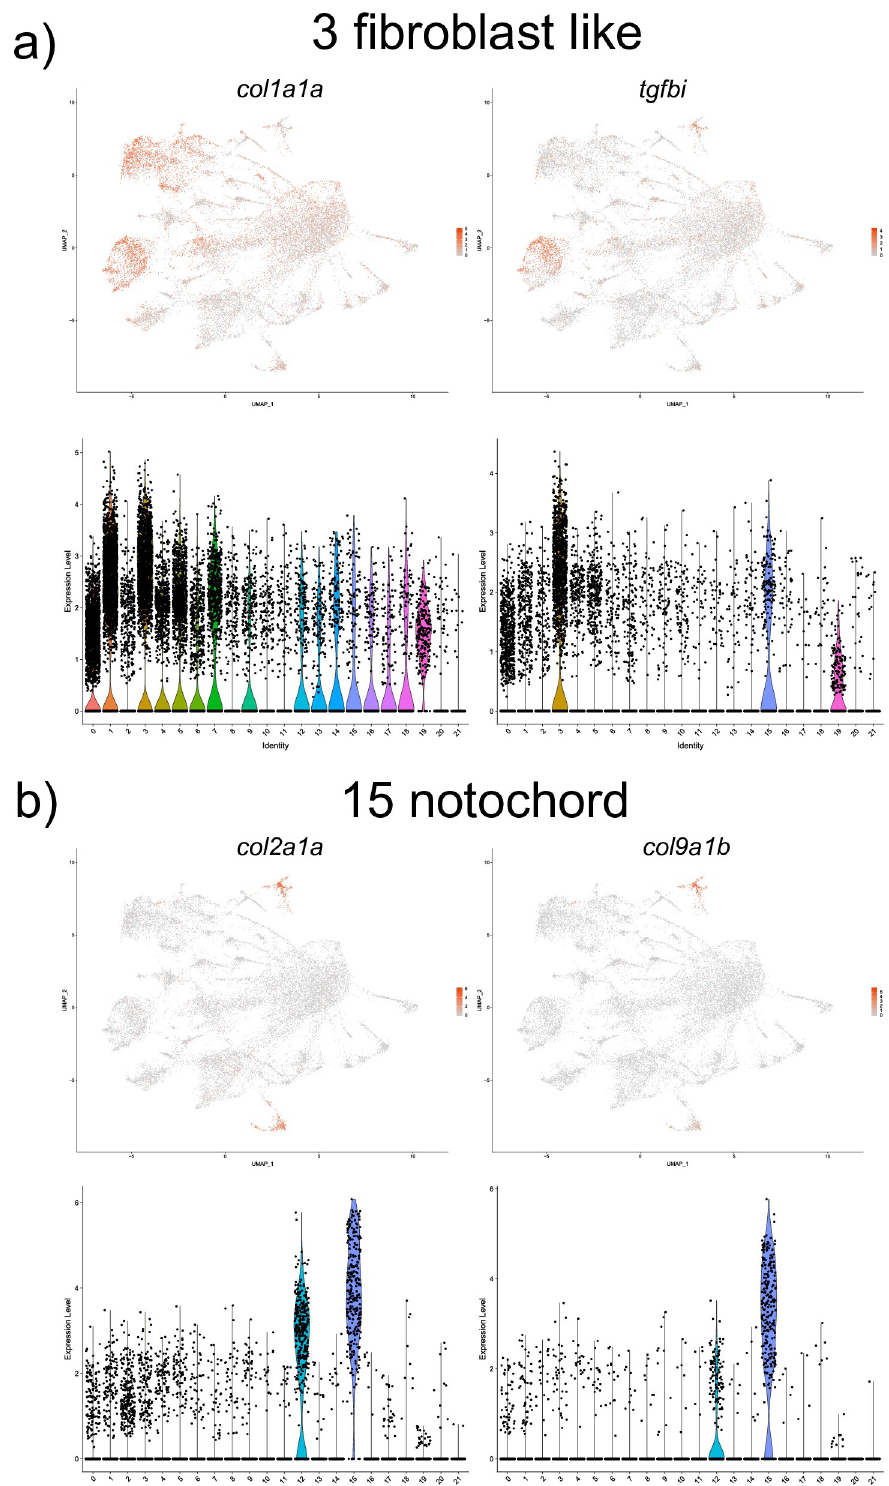
Fig 10. UMAP and violin plots showing the expression of selected marker genes for fibroblast like (cluster #3, a) and notochordal cells (cluster #15, b).